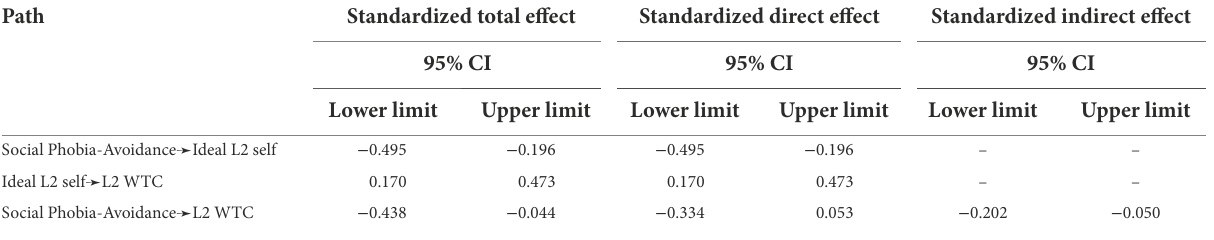
TABLE 6 Effect analysis of the paths (Social phobia-avoidance).